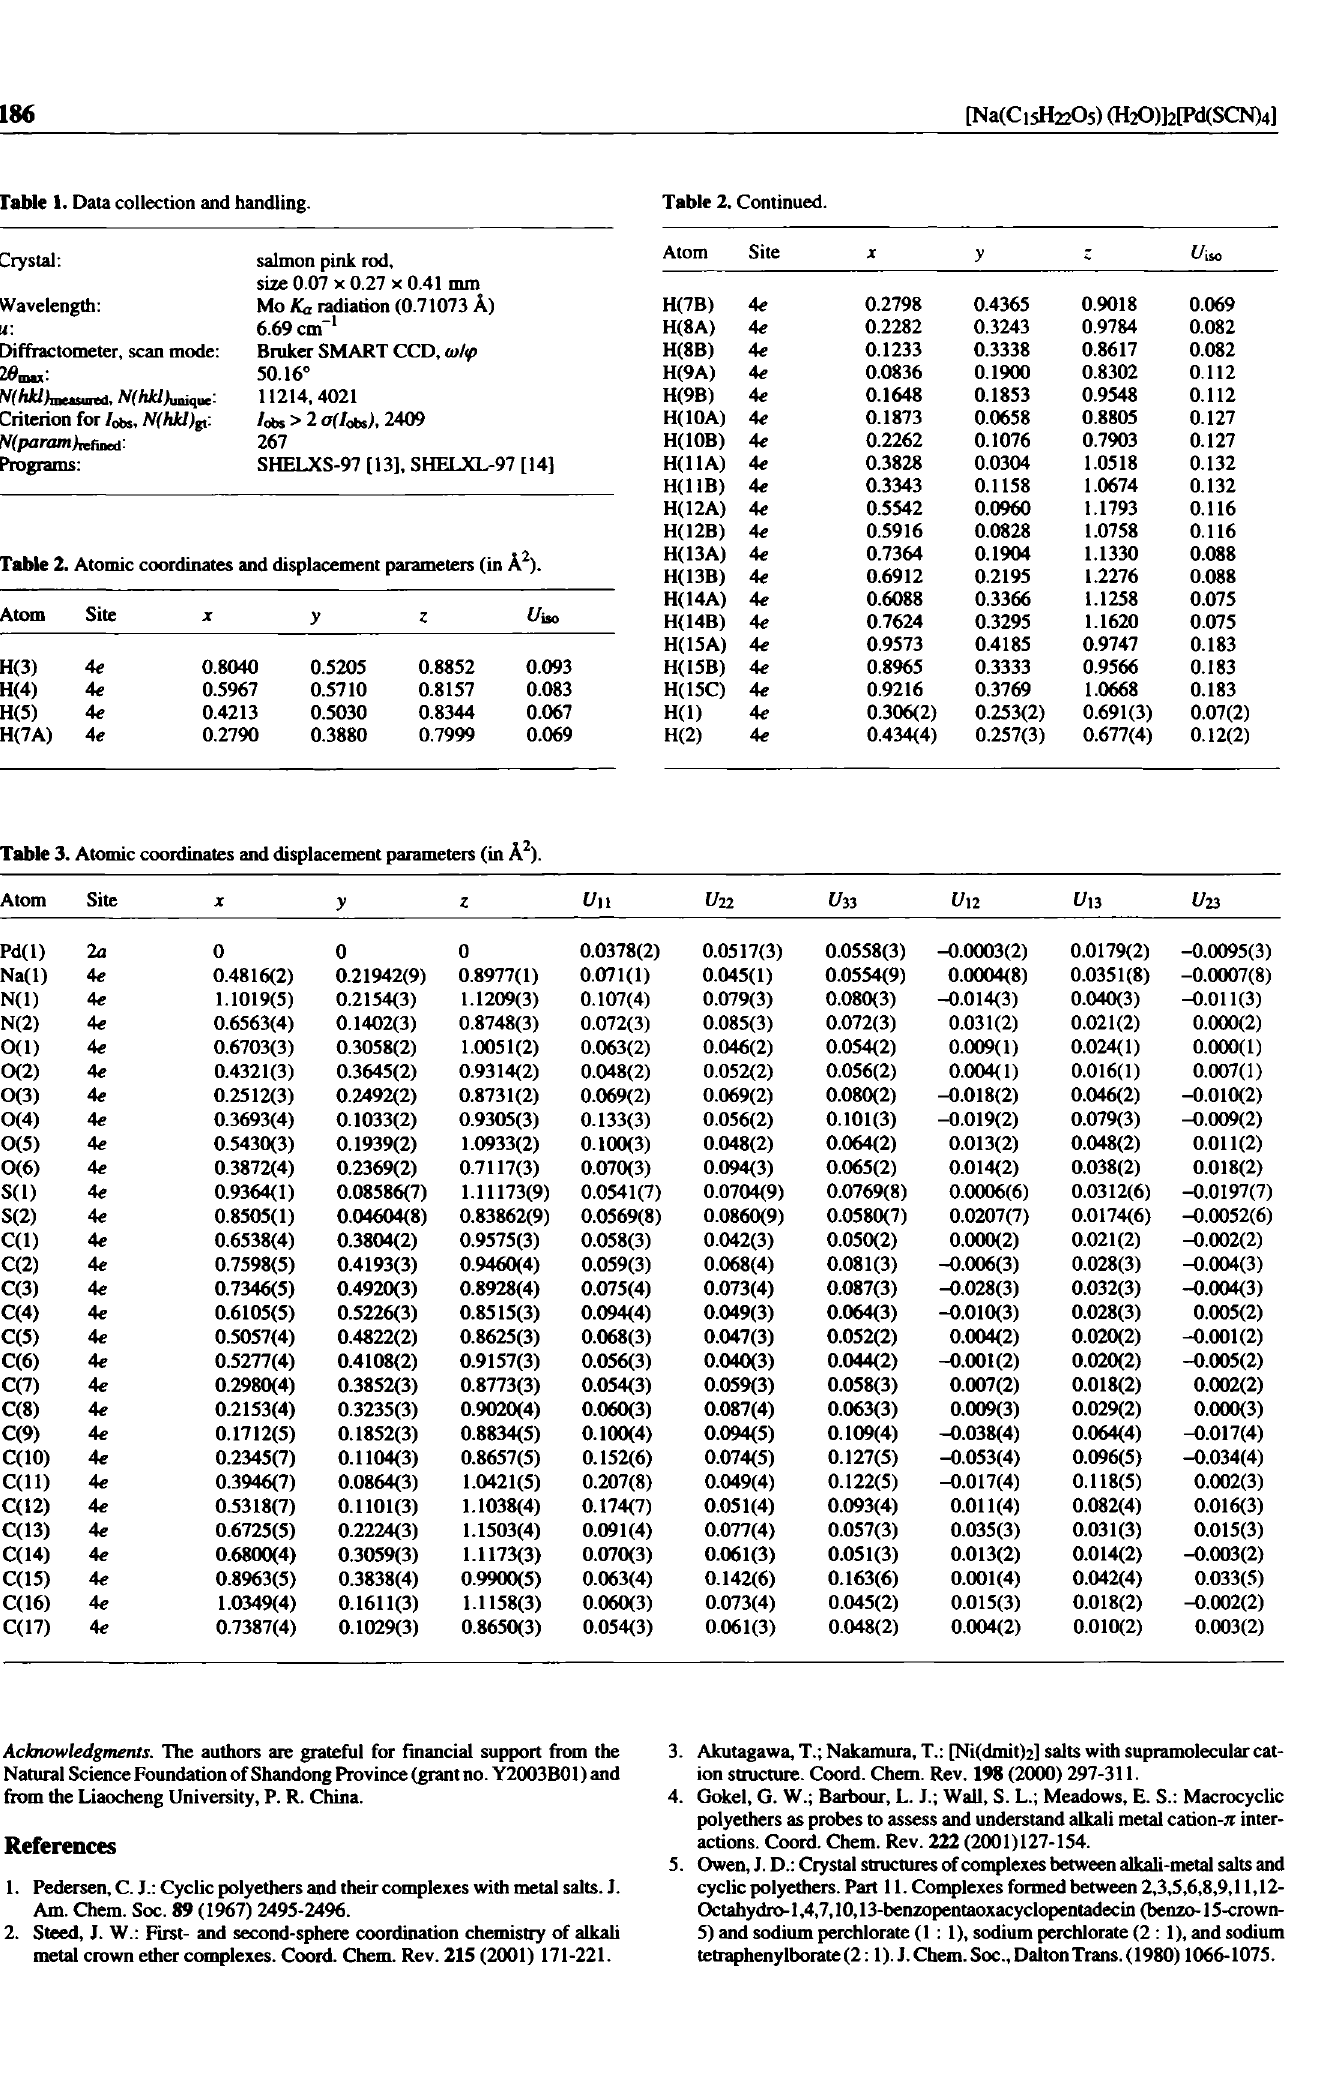
Table 2. Atomic coordinates and displacement parameters (in A 2 ).